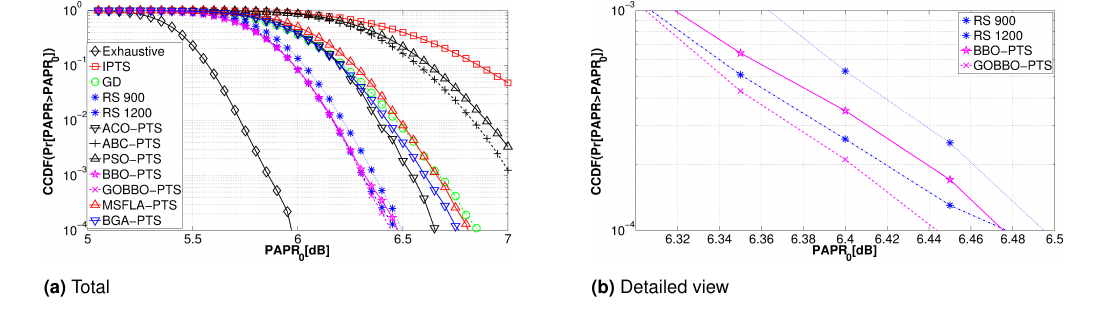
Fig. 6. PARP reduction performance comparison of the BBO-PTS algorithms with other PTS schemes for NP D 30 , G D 30 .